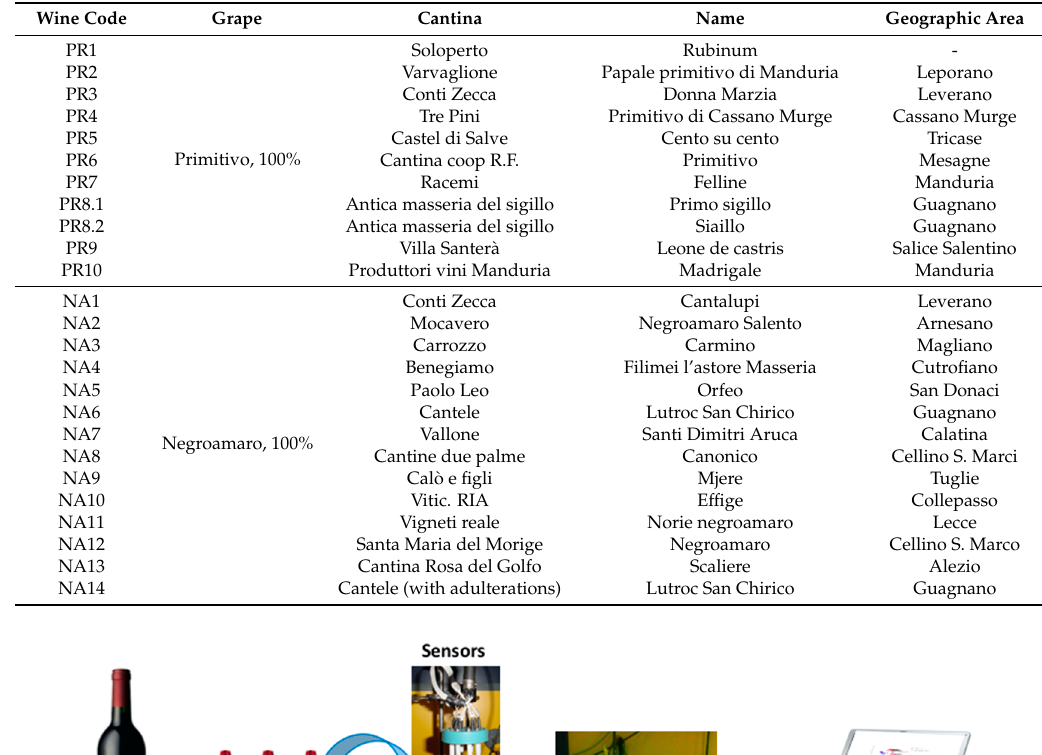
Table 2. The analysed wines. Year of production: 2007.